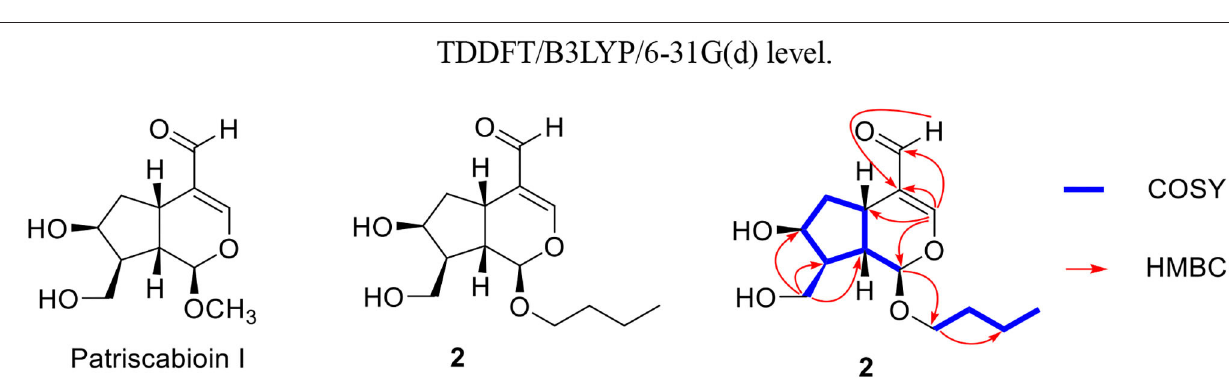
FIGURE 5 | Key 1 H- 1 H COSY and HMBC correlations of compound 2 and the structure of patriscabioin